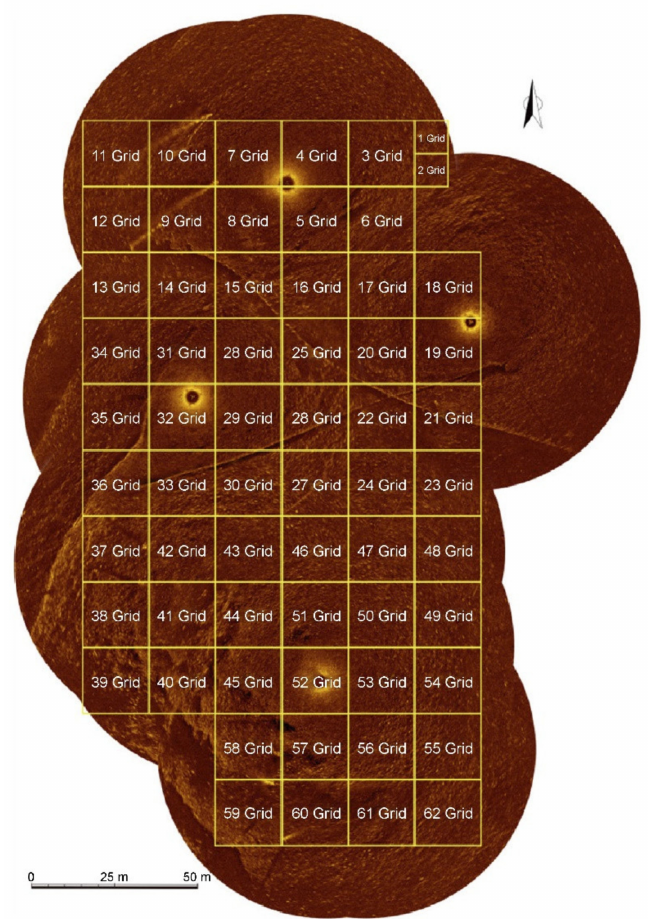
Figure 7. Scanning sonar image of section A of the Nakwoldo underwater excavation site (frequency: 675 kHz; swath: 50